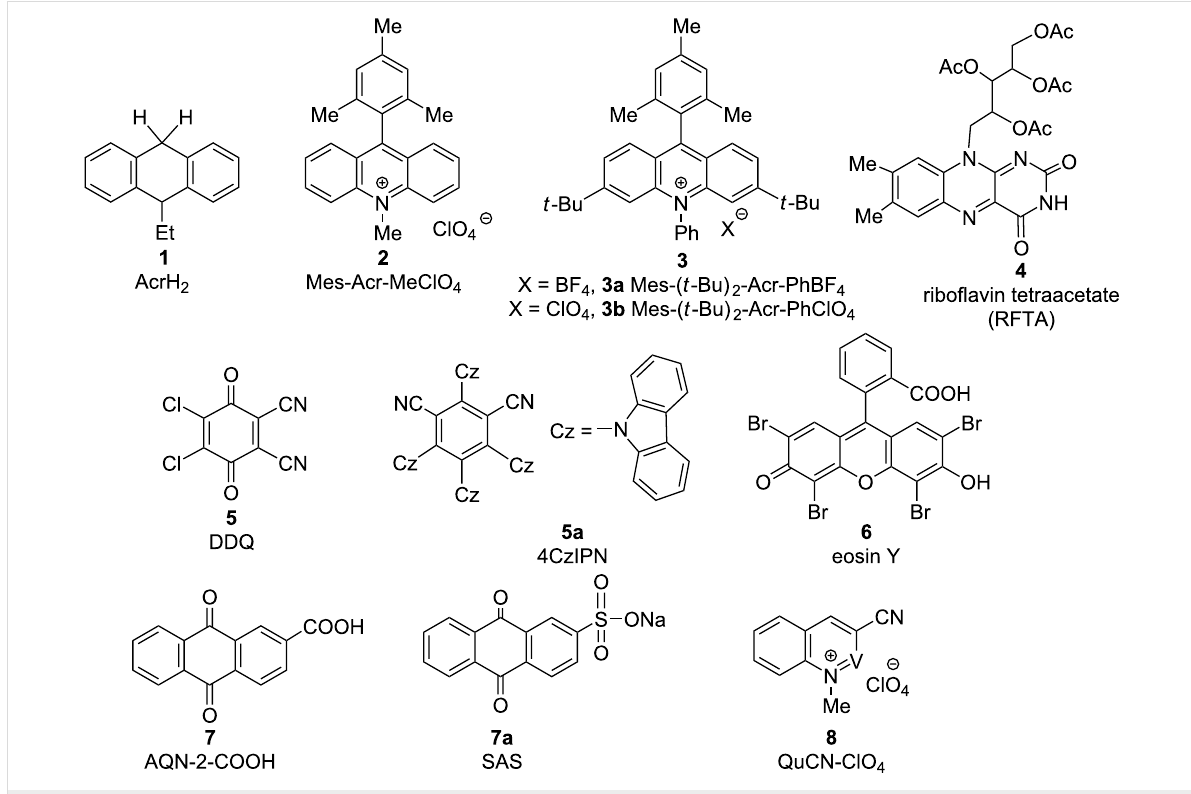
Figure 1: List of photoredox catalysts used for C–H bond functionalizations.